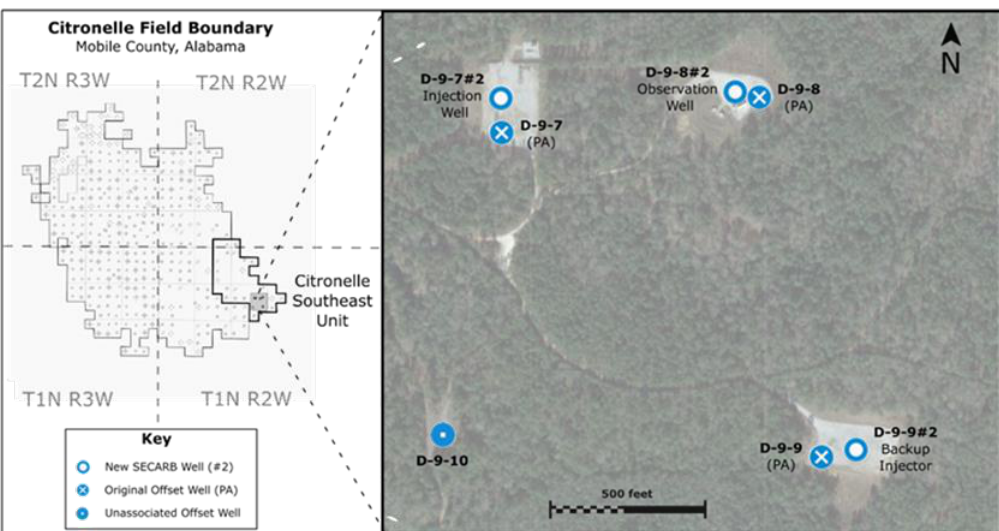
Figure 5. Map showing the location of both preexisting and newly drilled characterization wells at the Southeast Regional Carbon Sequestration Partnership Anthropogenic Test Site. #2 indicates the name of a new well drilled in 2011. PA indicates a plugged and abandoned well.